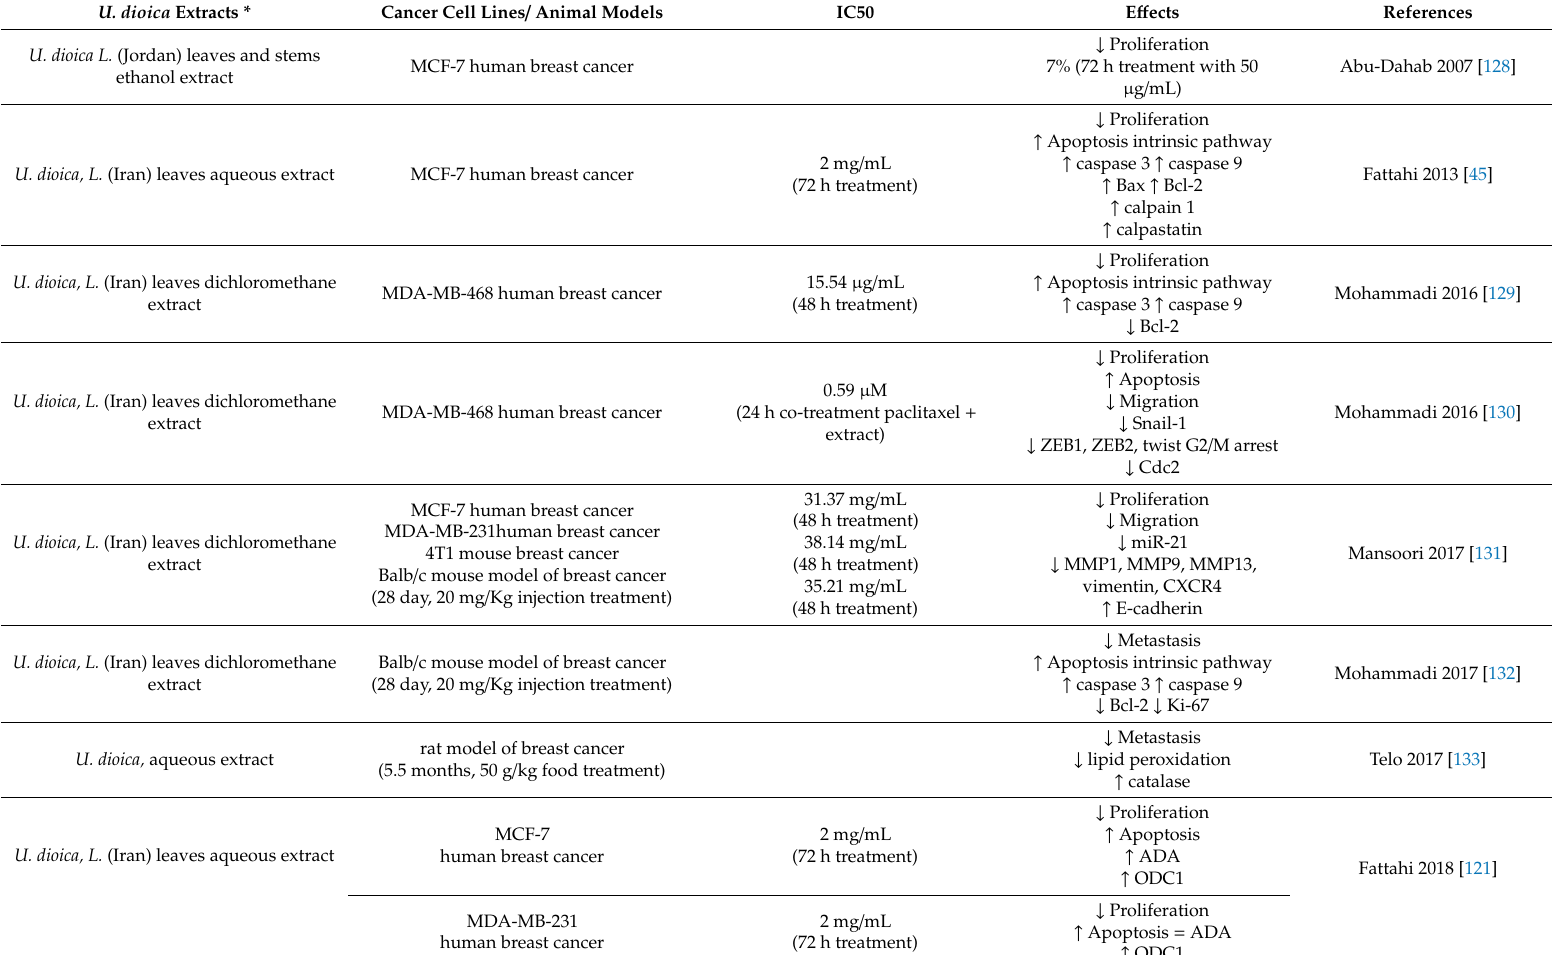
Table 4. Anti-cancer e ff ects of U. dioica : breast cancer, in-vitro and in-vivo